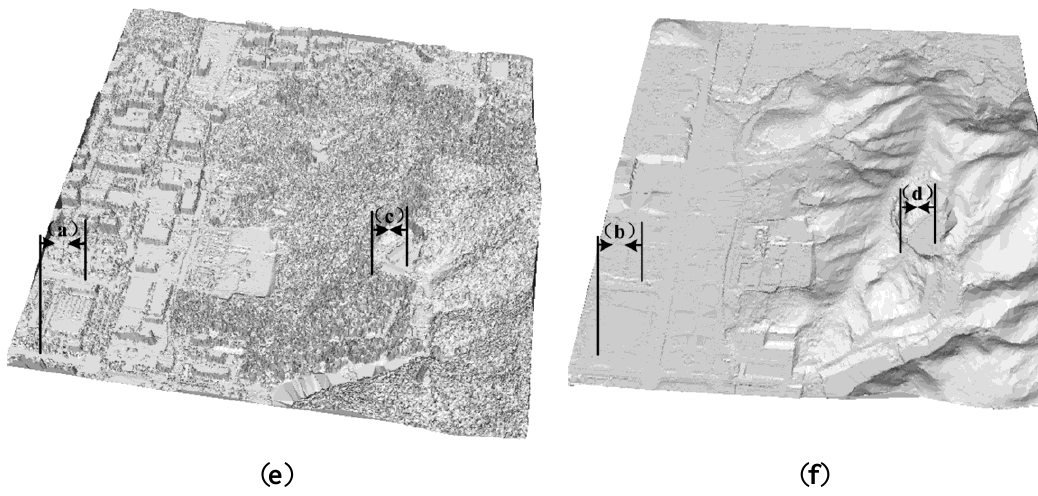
Figure 13. Removal of complex objects: ( a ), ( b ), ( c ), and ( d ) are cross sections; ( e ) is the raw point data; ( f ) is the DTM generated by